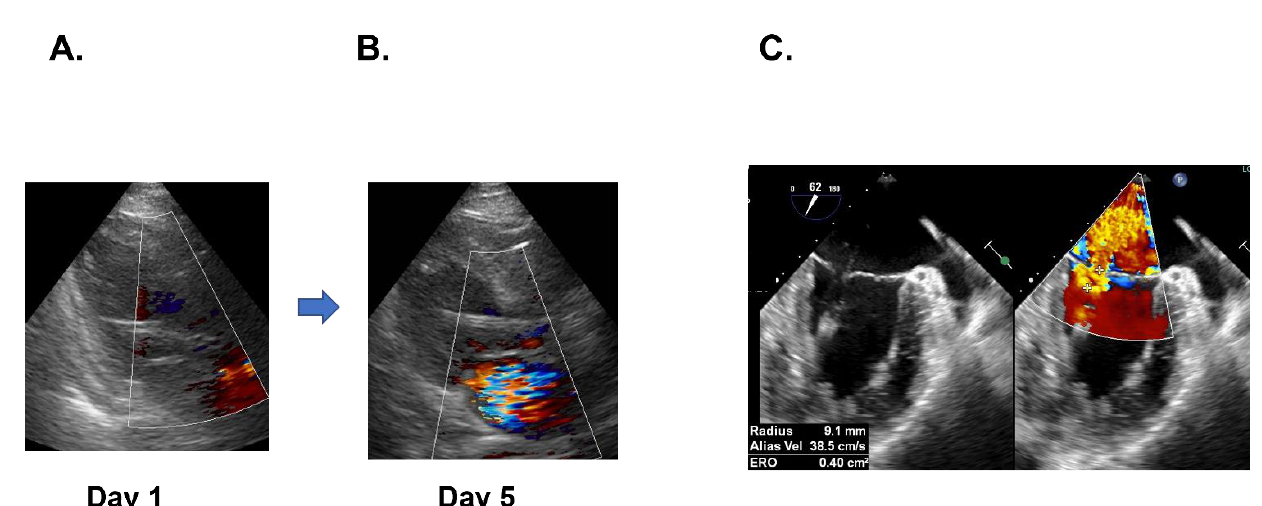
Figure 3. Mitral valve regurgitation was trivial on day 1 ( A ), however, it worsened to severe on day 5 on transthoracic echocardiography ( B ). Transesophageal echocardiography revealed the severe mitral valve regurgitation with prolapse of posterior leaflet and chordal rupture of posterior com- missure ( C